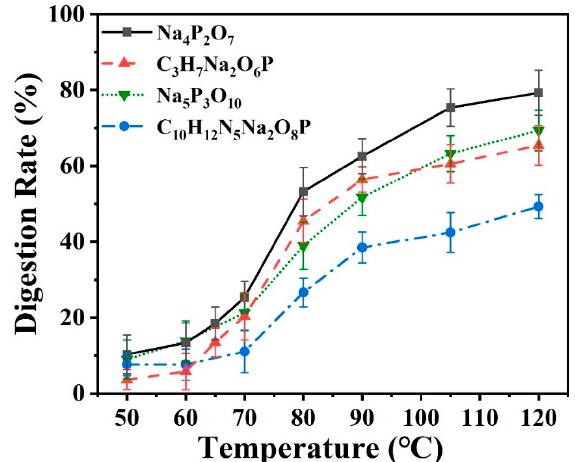
◦ ◦ Figure 5. The digestion temperature was adjusted and controlled between 50 C and 120 C. It was found that K 2 SO 4 lost its oxidizing activity and all phosphate nearly remained undigested when the ◦ temperature was set below 60 C. With the increase of temperature, the digestion rate of the four kinds ◦ of phosphate rises sharply and reaches the highest rate at 120 C, which indicated that the e ff ect of temperature on the digestion was very large. The digestion rate of tetrasodium pyrophosphate was the highest, followed by sodium glycerophosphate and sodium tripolyphosphate, and that of disodium (cid:48) guanosine 5 -monophosphate was the lowest. The details for the digestion mechanism will be given ◦ later. However, when the temperature exceeded 100 C, gas bubbles were occasionally generated in the microchannel [21]. Therefore, for this kind of optofluidic device, it is better to keep the reaction ◦ temperature at 90 C.